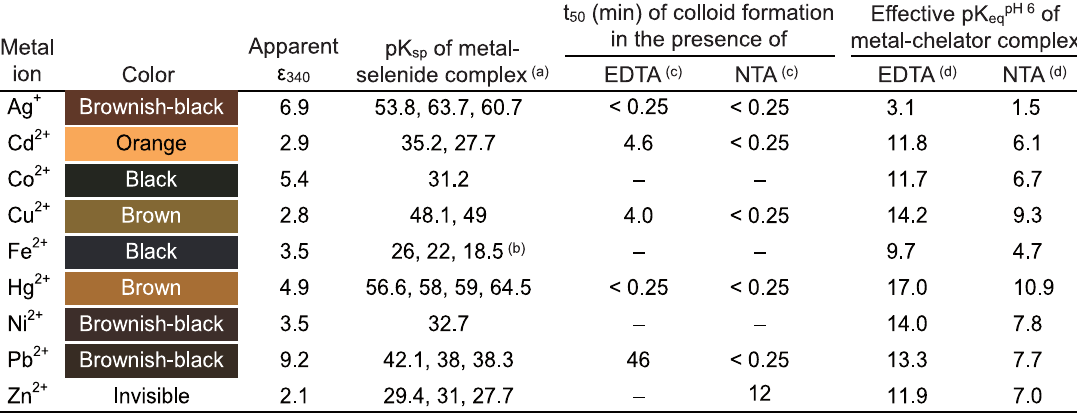
Figure 1. Colors and apparent molar turbidity coefficients of metal-selenide colloids. Indicated colors are those of samples containing 100 m M sodium selenide and 200 m M of each studied metal ion and incubated for 10 min. Apparent molar turbidity coefficients ( e 340 ) were deduced from the data in Fig. 2, assuming that, when the metal is in excess, all the selenium has passed from the soluble phase to the colloidal phase. Under our conditions, zinc selenide colloid formation could be evidenced at 340 nm (Fig. 2) but remained invisible to the eye. Nevertheless, after centrifugation, a light yellow precipitate could be recovered. (a) pK sp values of the metal selenide complexes, taken from Se ´ by et al. [12], correspond to the equilibriums M 2 + + Se 2– u MSe (divalent cations) or 2 Ag + + Se 2– u Ag 2 Se (silver ion). Of note, in many cases, different pK sp values are available in the literature for a same complex. (b) In the case of Fe 2 + , the pK sp value that we determined in this study from data in Fig. 2 is also shown. (c) Sodium selenide (50 m M) was added to a mixture of metal ion (100 m M) and of either EDTA or NTA (1 mM). The sample was incubated anaerobically in a 50 mM MES buffer (pH 6.0) for 3 h. Metals for which colloid formation was no longer observed in the presence of the chelator are labeled with ‘‘ – ’’ (minus). For the metals which still produced colloids, t 50 was measured. (d) Effective equilibrium constants of the chelator-divalent metal complexes at pH 6.0 (K eqpH 6 ) [64] were calculated using absolute equilibrium constants of these complexes (M.EDTA 2 2 or M.NTA 2 ) and protonation pK values of 0.0, 1.5, 2.0, 2.68, 6.11 and 10.17 for EDTA and of 0.8, 1.8, 2.48 and 9.65 for NTA [65]. In the case of the monovalent Ag + ion, effective pK eqpH 6 values were drawn from equilibrium constants of the Ag.EDTA 3 2 , Ag.H-EDTA 2 2 and Ag.NTA 2 2 complexes [65].